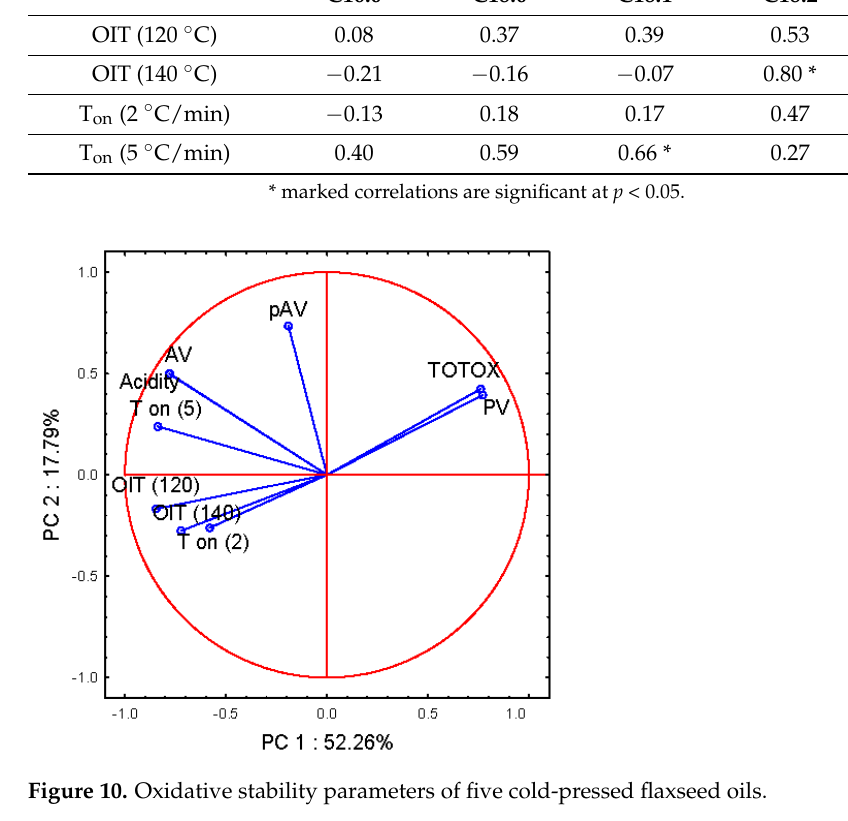
Table 7. Pearson’s correlation coefficients between fatty acid composition and oxidative stability parameters measured by DSC.